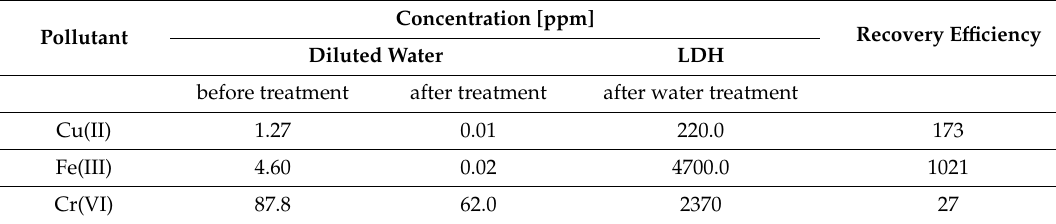
Table2. PollutantamountinthedilutedwastewaterbeforeandaftertreatmentwiththeMgAl-CO 3 LDH. Concentration Pollutant